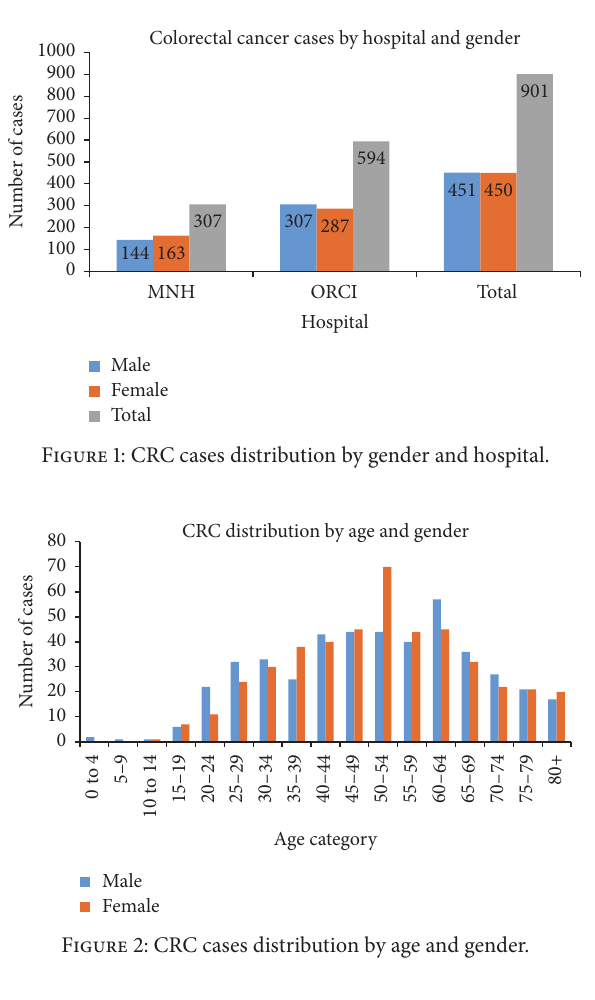
patients was not statistically significant ( 𝑃 = 0.724 ).